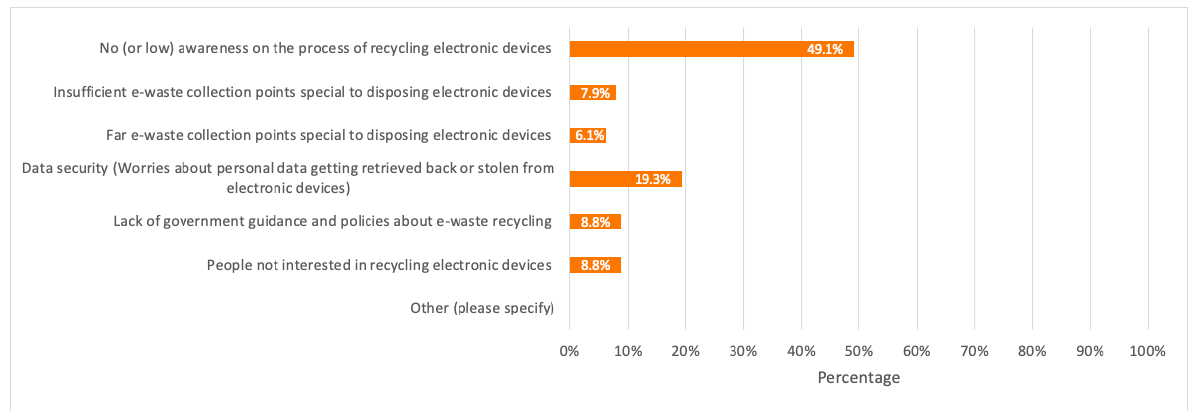
Figure 6. Respondents’ participation in recycling electronic devices.